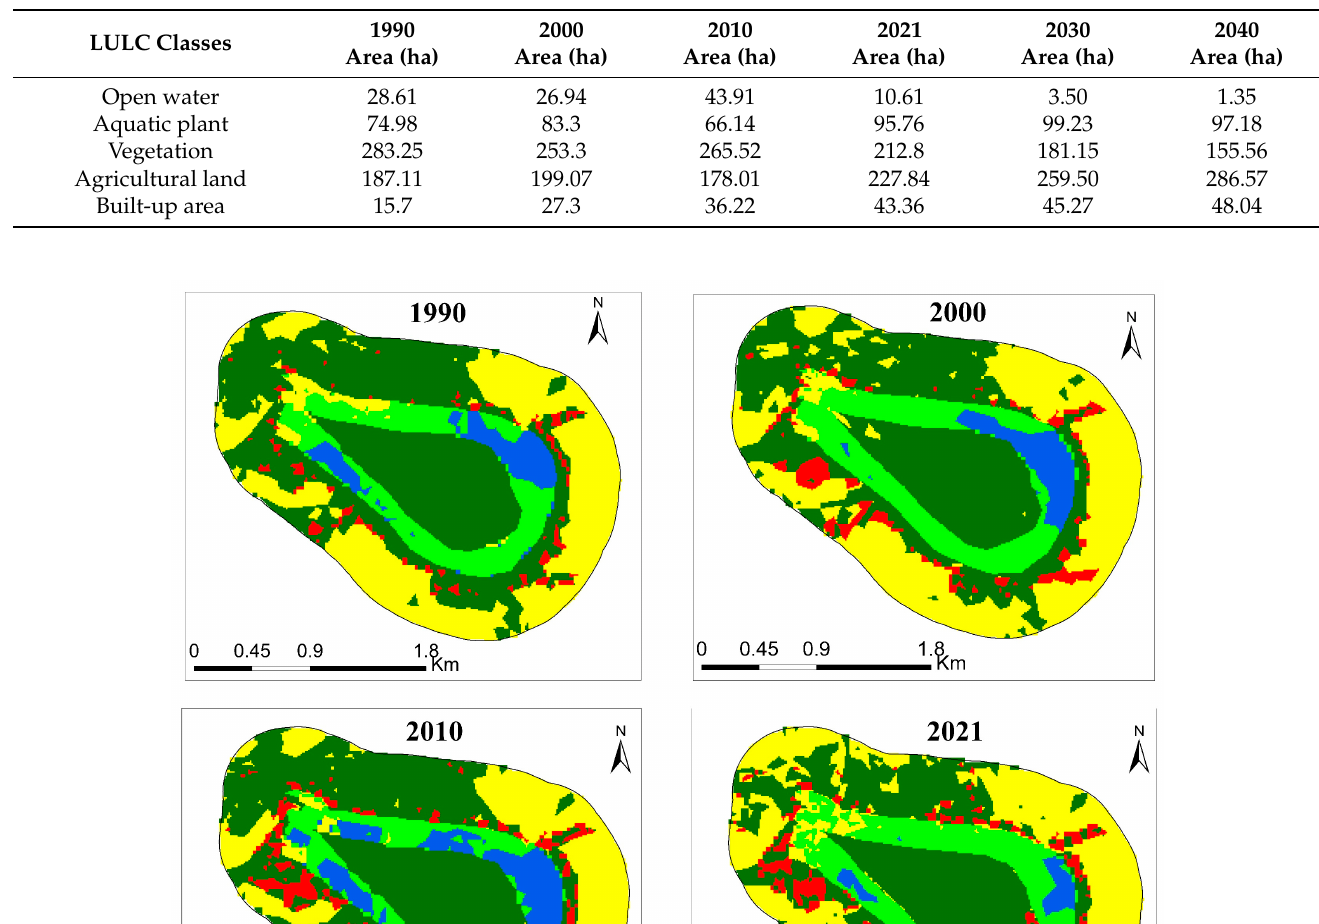
Table 4. Areal extents of land-use/land-cover (LULC) types from 1990 to 2040.